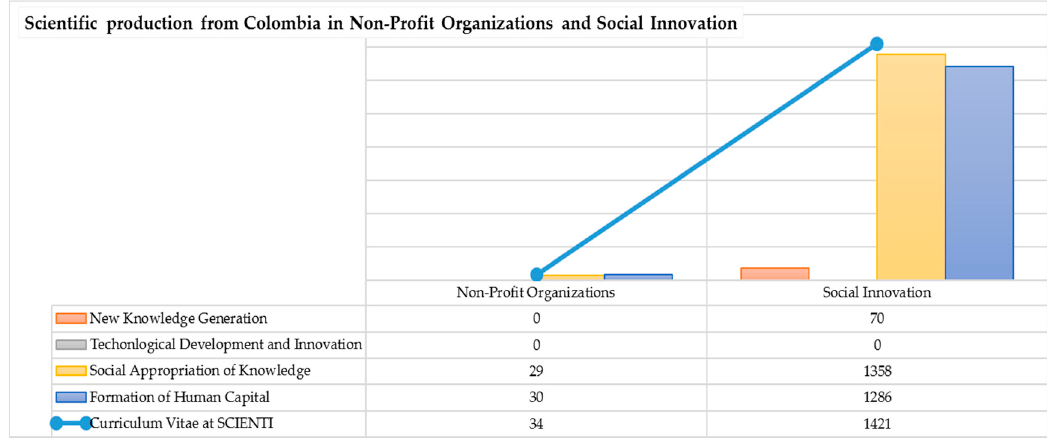
Figure 4. Colombian scientific production on social innovation and non-profit organizations fields. Source: Query on National System of Science, Technology, and Innovation of Colombia (SCIENTI)– COLCIENCIAS